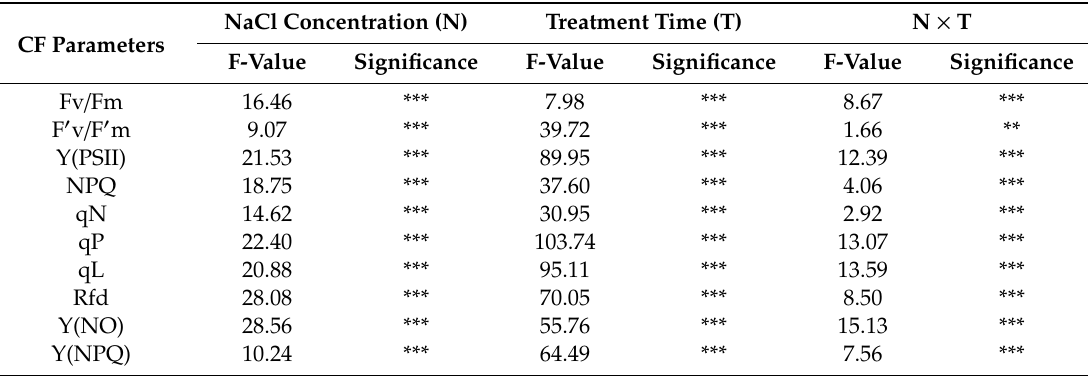
Table 3. Summary of analysis of variance of chlorophyll florescence (CF) parameters in lettuce seedlings at the NaCl concentration and treatment